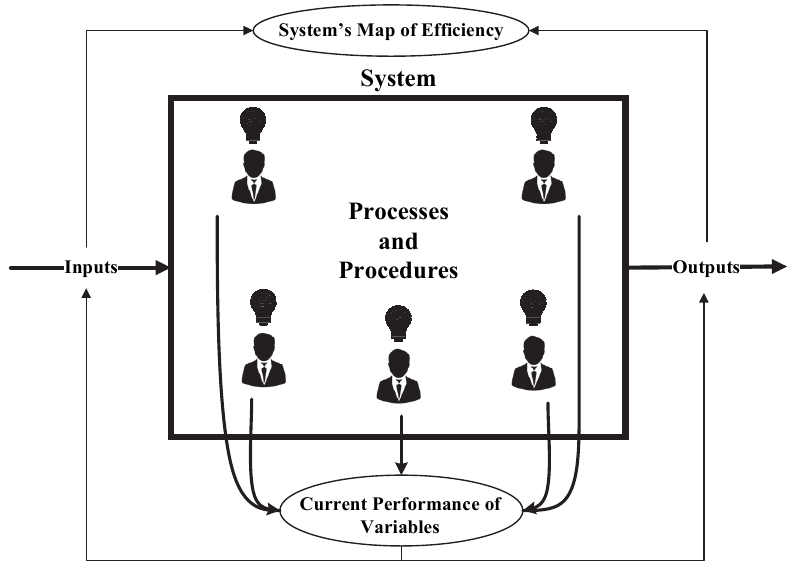
Fig. 4. Performance evaluation of system’s variables using